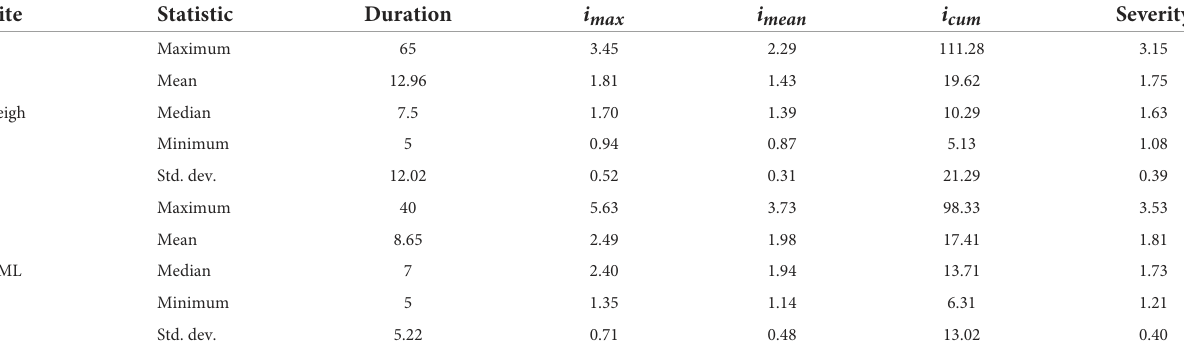
TABLE 1 Summary MHW statistics for Leigh and PML including the duration, maximum intensity ( i max ), mean intensity ( i mean ), cumulative intensity ( i cum ), and severity.